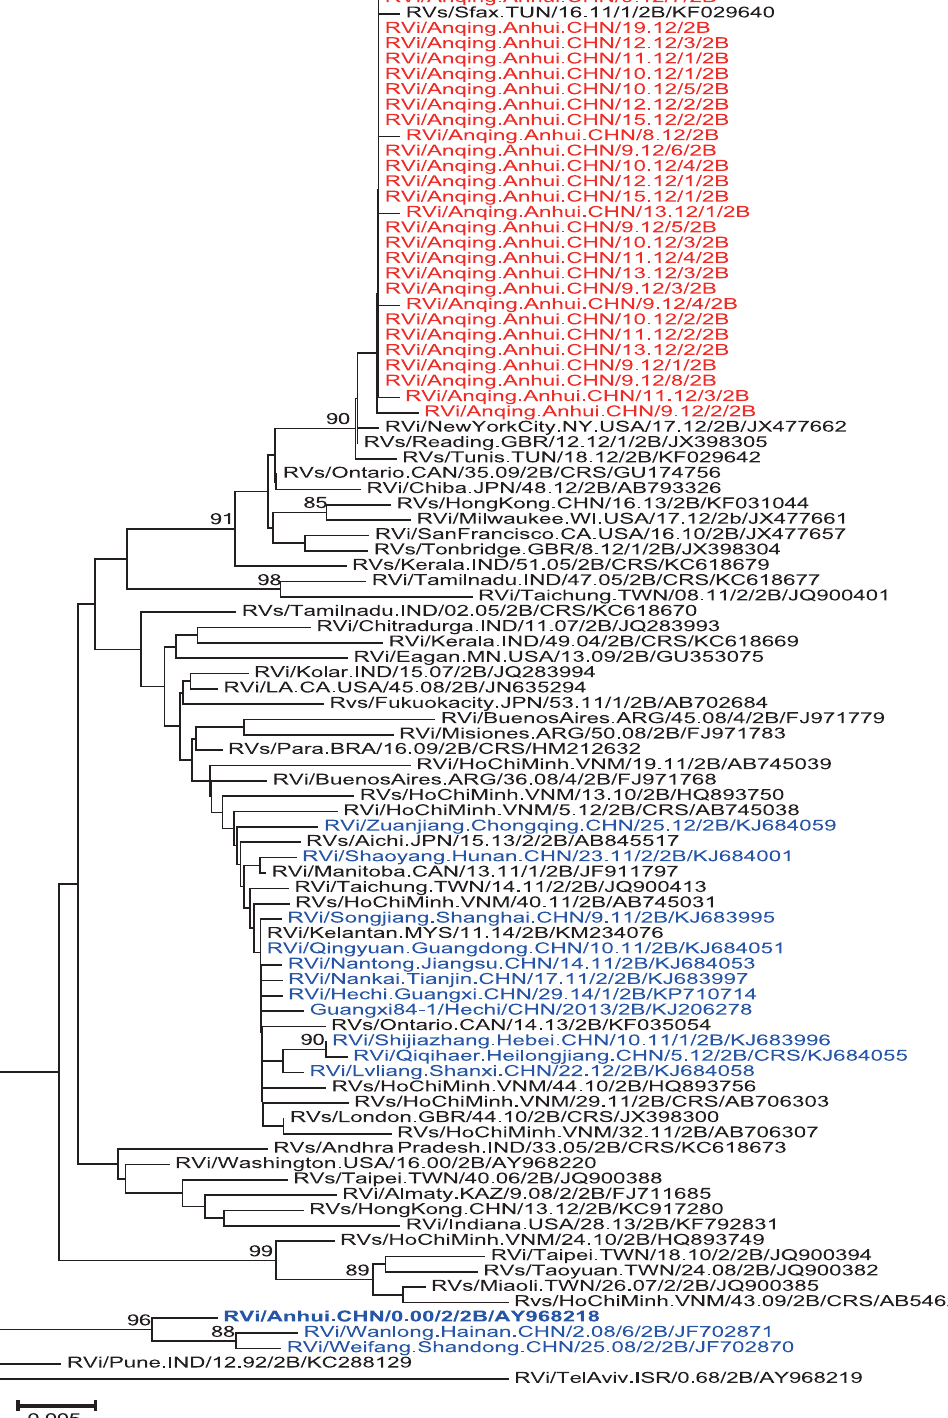
Fig 5. Phylogenetic analysis of the sequences of 27 RVs from the outbreak in Anqing city (shown in red), 14 domestic genotype 2B RVs (2000 – 2014) (shown in blue), and 50 international genotype 2B RVs (1968 – 2014) downloaded from the GenBank database based on the WHO standard 739-nt